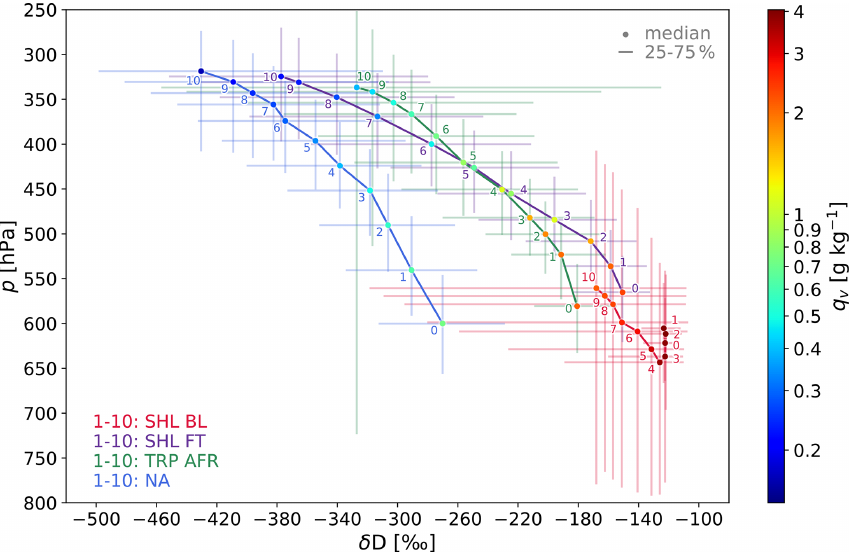
Figure 9. p – δ D plot summarising the 10d Lagrangian history of COSMO iso air parcels arriving at 500–700hPa above Tenerife. The plot shows the median p and δ D of the air parcels by the filled circles and the median q v by the colours of the filled circles. The numbers indicate the days before the air parcels arrive over Tenerife, where red numbers represent air parcels from the boundary layer of the Saharan heat low (SHL BL), purple numbers air parcels from the free troposphere above the Saharan heat low (SHL FT), green numbers air parcels from tropical Africa (TRP AFR), and blue numbers air parcels from the North Atlantic (NA). The interquartile range of p and δ D is shown by the coloured vertical and horizontal